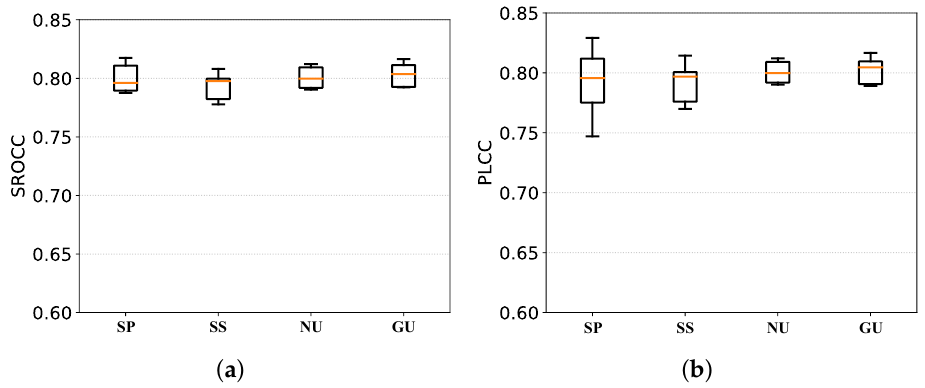
Figure 12. Comparison of box plots for the four alignment methods. ( a ) SROCC of four alignment strategies. ( b ) PLCC of four alignment strategies.